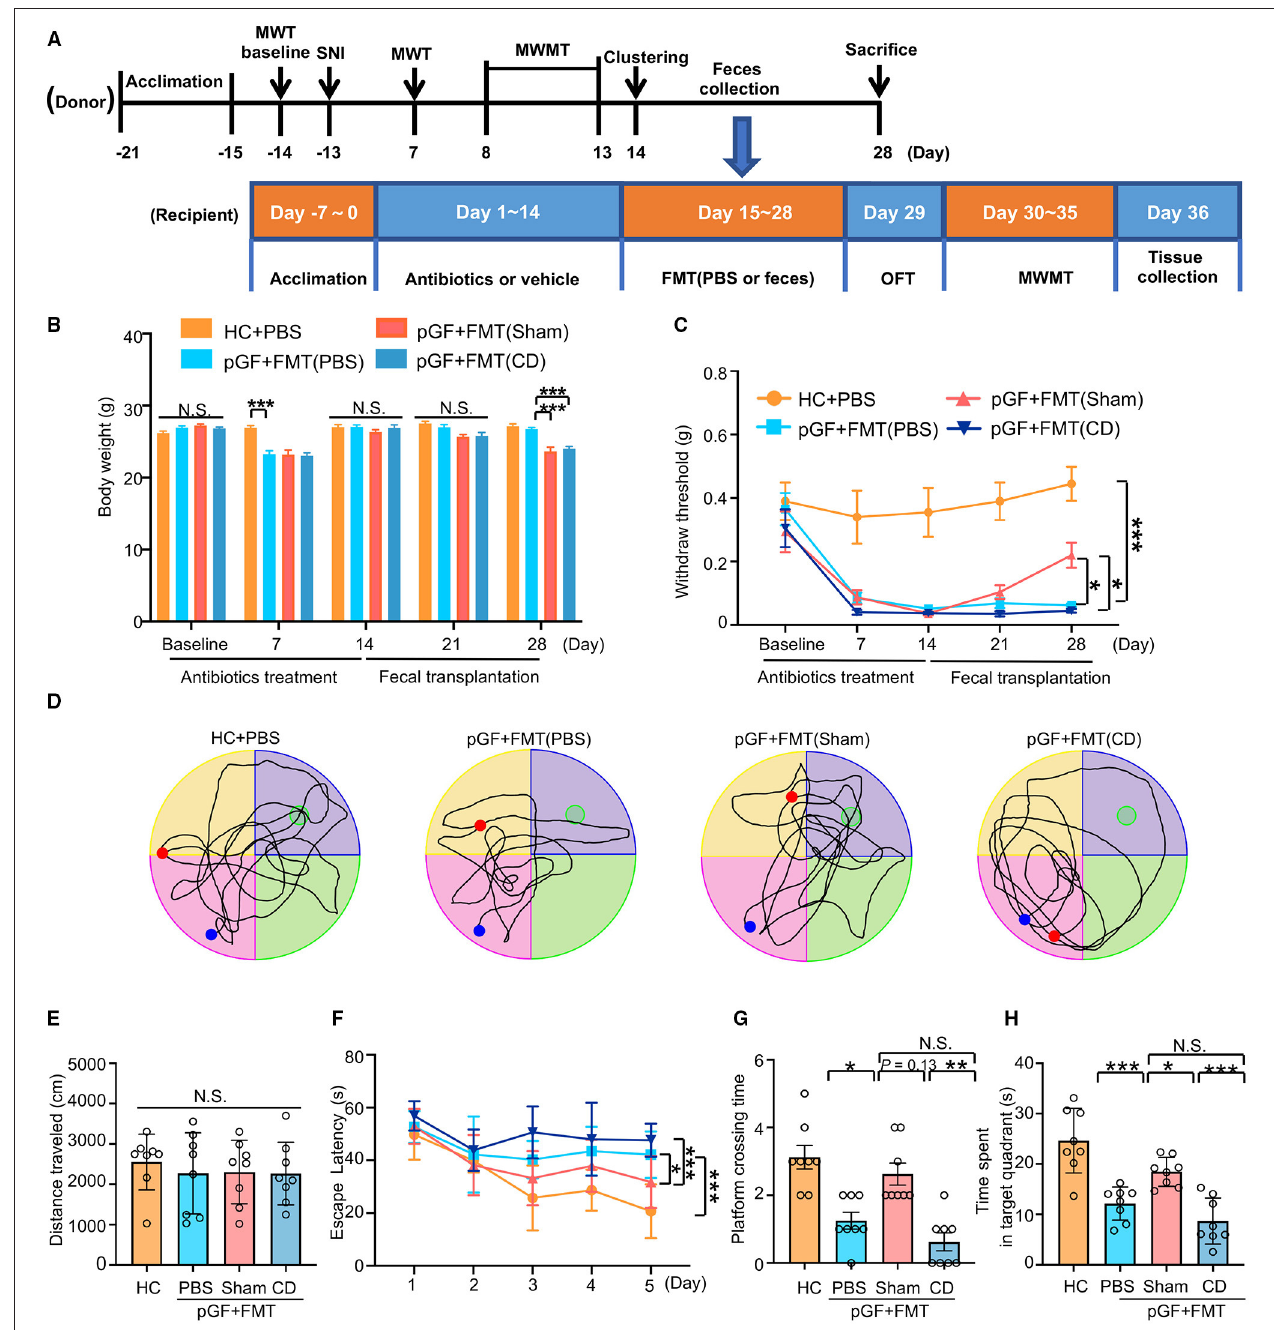
FIGURE 6 | Fecal microbiota transplantation (FMT) from mice of Sham reversed nociception and cognitive impairment in pseudo-germ-free (pGF) mice. (A) Experiment schedule of the fecal microbiota donor and receptor mice. To ensure the vitality of the intestinal flora, 1g fresh feces were collected from the donor mice and then immediately dissolved in 10ml phosphate-buffered saline (PBS) to prepare suspension for later FMT. For the donor mice, 10-month-old C57 mice were acclimated to the environment from day 21 to day 15 and performed SNI on day 13. MWMT was carried out from day 8 to day 13. After clustering into SNI with CD or NCD group, feces were collected before the FMT from day 15 to day 28. Donor mice were sacrificed after feces collection on day 28. For the receptor mice, 2-month-old C57 mice were treated with broad-spectrum antibiotics in drinking water for 14 consecutive days (day 1 to day 14). Subsequently, mice were treated with 0.2ml PBS or fecal microbiota suspension obtained from Sham and CD group mice by oral gavage once a day for 14 consecutive days (day 15 to day 28). MWT and body weight were measured on day 1 (baseline), 7, 14, 21, and 28 after SNI. The collection of tissues was performed after MWMT on day 35 after SNI. (B) Body weight [two-way RM ANOVA; Time: F (4, 140) = 41.8, P < 0.001; Group: F (3, 140) = 24.76, P < 0.001; Interaction: F (12, 140) = 8.544, P < 0.001]. (C) MWT [two-way RM